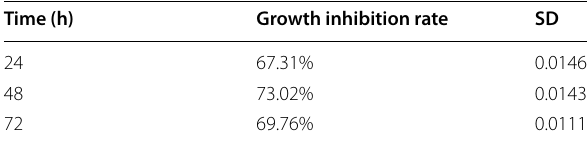
Table 8 Inhibition of NDUFV2 gene silencing on the proliferation of MCF-7/ADR cells: the growth inhibition rate of